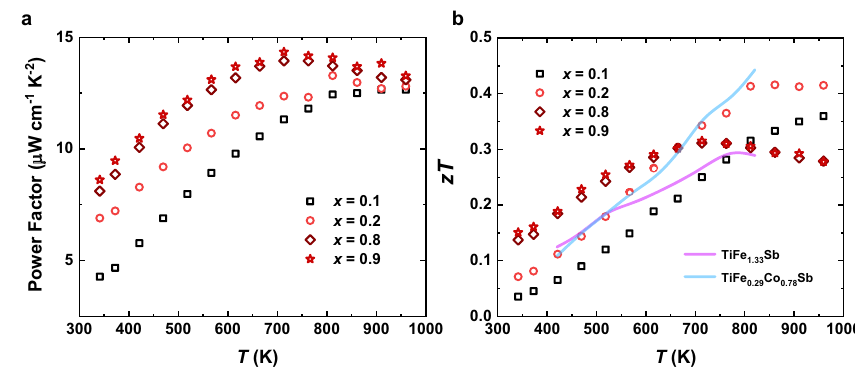
Fig. 7 Thermoelectric properties of TiRu 1 + x Sb. a Thermoelectric power factors. b zT values. The temperature-dependent zT values of p-type TiFe 1.33 Sb 6 and TiFe 0.29 Co 0.78 Sb 6 are included